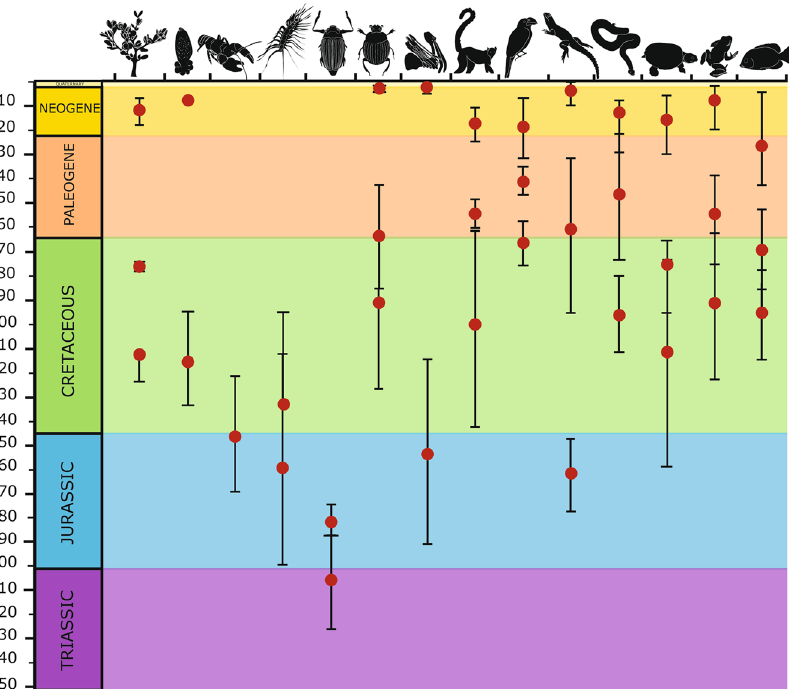
Figure 5. Summary diagram of age estimates of endemic Malagasy lineages. Within each group of organisms the oldest, a middle, and youngest estimated clade ages are depicted. Red dot is the median age estimate and error bars are the min and max intervals from the original study compiled from the literature (Table S2). Only those lineages with median, minimum and maximum age estimates were included in the figure. Groups from left to right are plants, trematodes, decapods, centipedes, heterogyrine whirligig beetles (showing tip and node dating ages), insects (excluding whirligig beetles), spiders, mammals, birds, lizards, snakes, testudines, amphibians, and